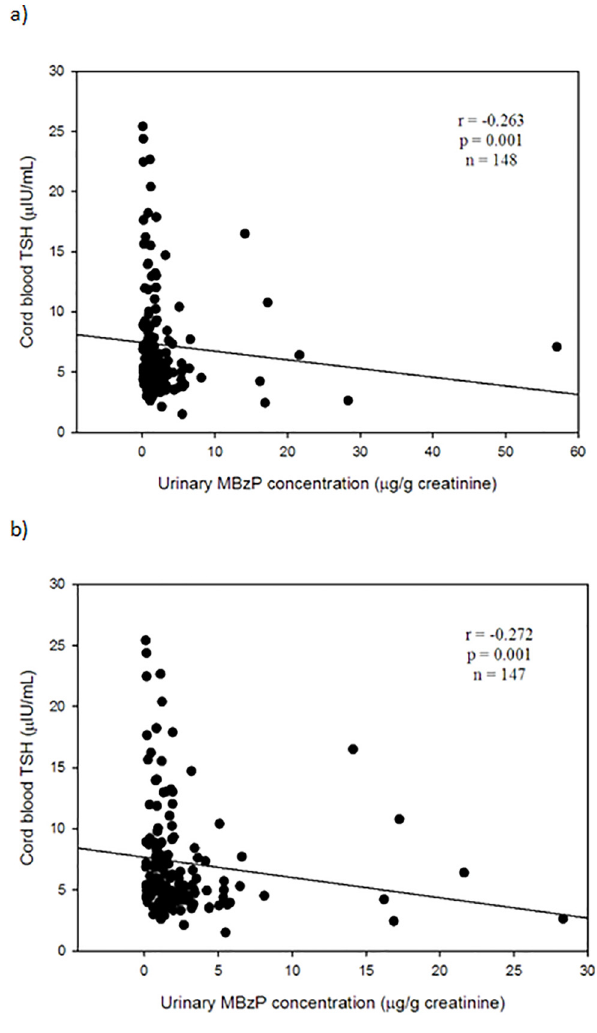
Fig 1. Relationship between urinary MBzP levels and TSH levels in cord blood serum. a) In total (n = 148); b) One outlier exclusion (n = 147). Abbreviation: MBzP = mono-benzyl phthalate; TSH = thyroid- stimulating